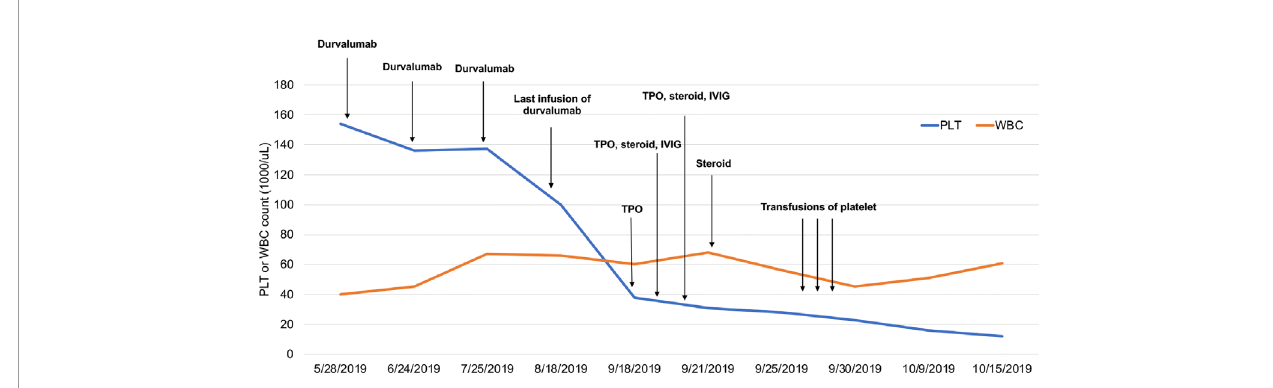
FIGURE 1 | Platelet and WBC counts following immunotherapy with durvalumab. WBCs are multiplied by 10 2